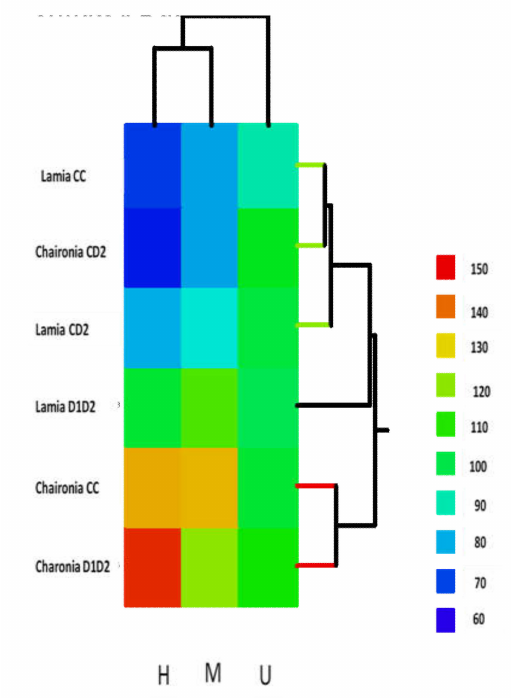
Figure 7. The permuted data matrix is actually a heat map presentation of the six di ff erent treatments in a three-variable classification space (h-, m-, and u-methylation). The distance measure is the Euclidean distance, and the joining method is the single linkage. Three clusters are formed in the variety’s domain. Importantly, these clusters present the peculiarity of the Chaironia CD2 to be clustered together with Lamia CC and Lamia CD2 to form a cluster alone. Table 4. Mean epigenetic Shannon Information Index (Iepi) and epigenetic diversity (hepi) and standard error (SE) for treatments for each cultivar. The significant di ff erences that are provided from Dunn’s post hoc tests with Bonferroni correction among treatments for each variety are indicated with the same